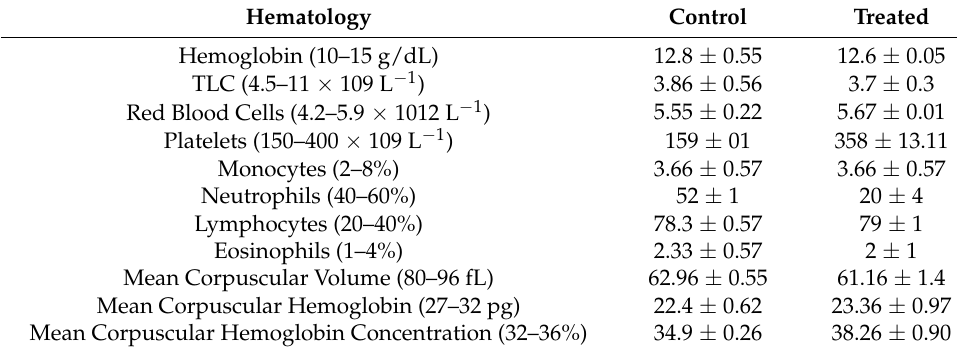
Table 5. Biochemical analysis of blood.